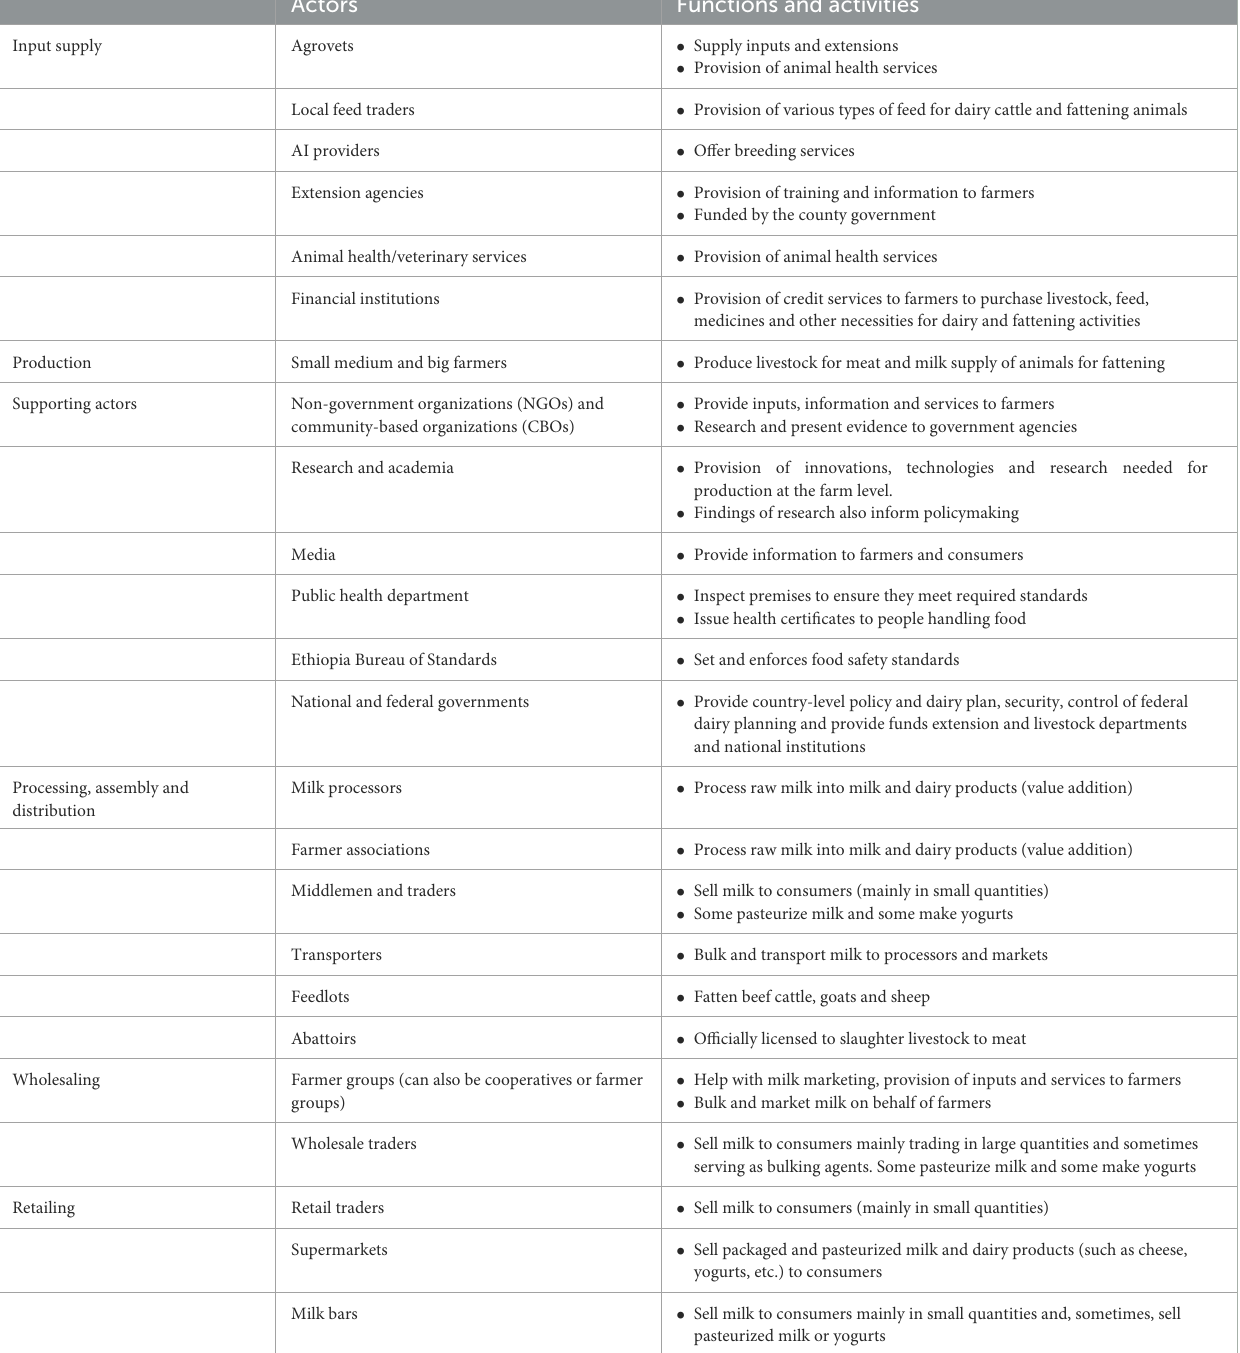
TABLE 2 Key milk and meat value chains actors and their